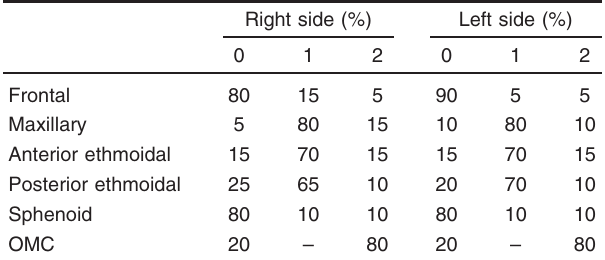
Table 2 Computed tomography sinus score in the patients in group II Right side (%)